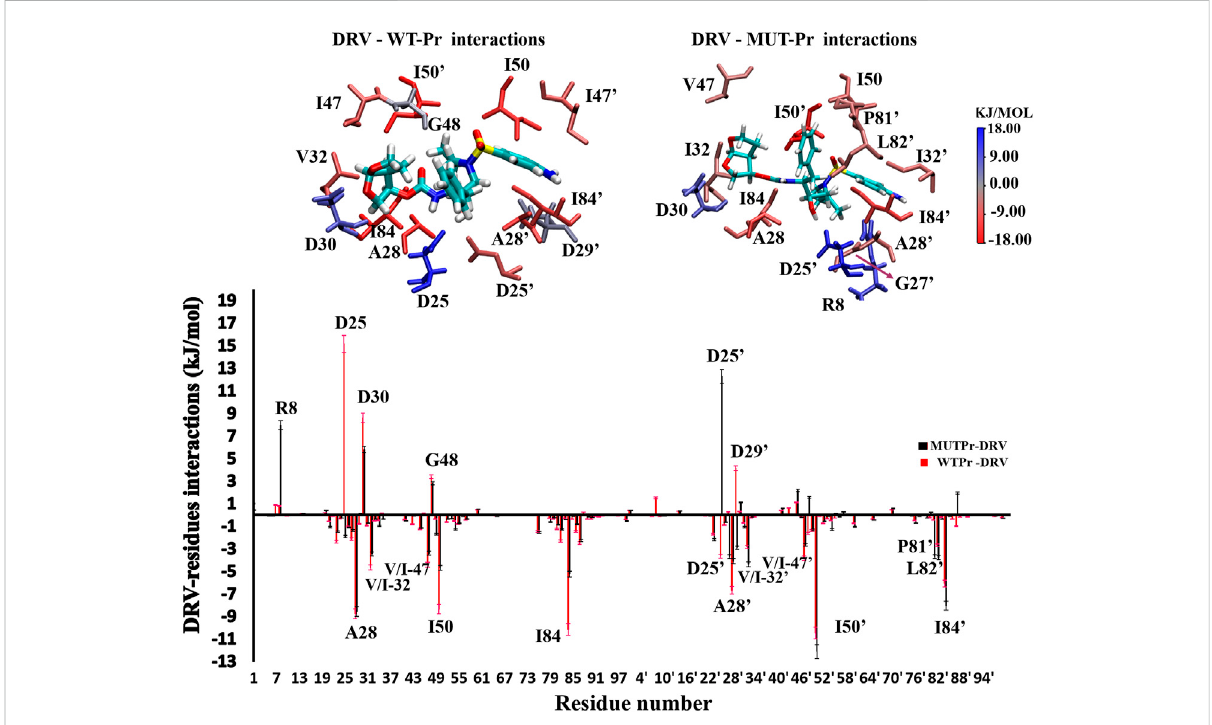
FIGURE 6 Down:residualspectrumofbindingenergywithDRV.Up:Thegroupofinteractionsconsistsofresiduesintotalwiththebindingenergyequalto or more than +/ − 3 kj.mol − 1 was be showed, and their binding potency was determined visually by color